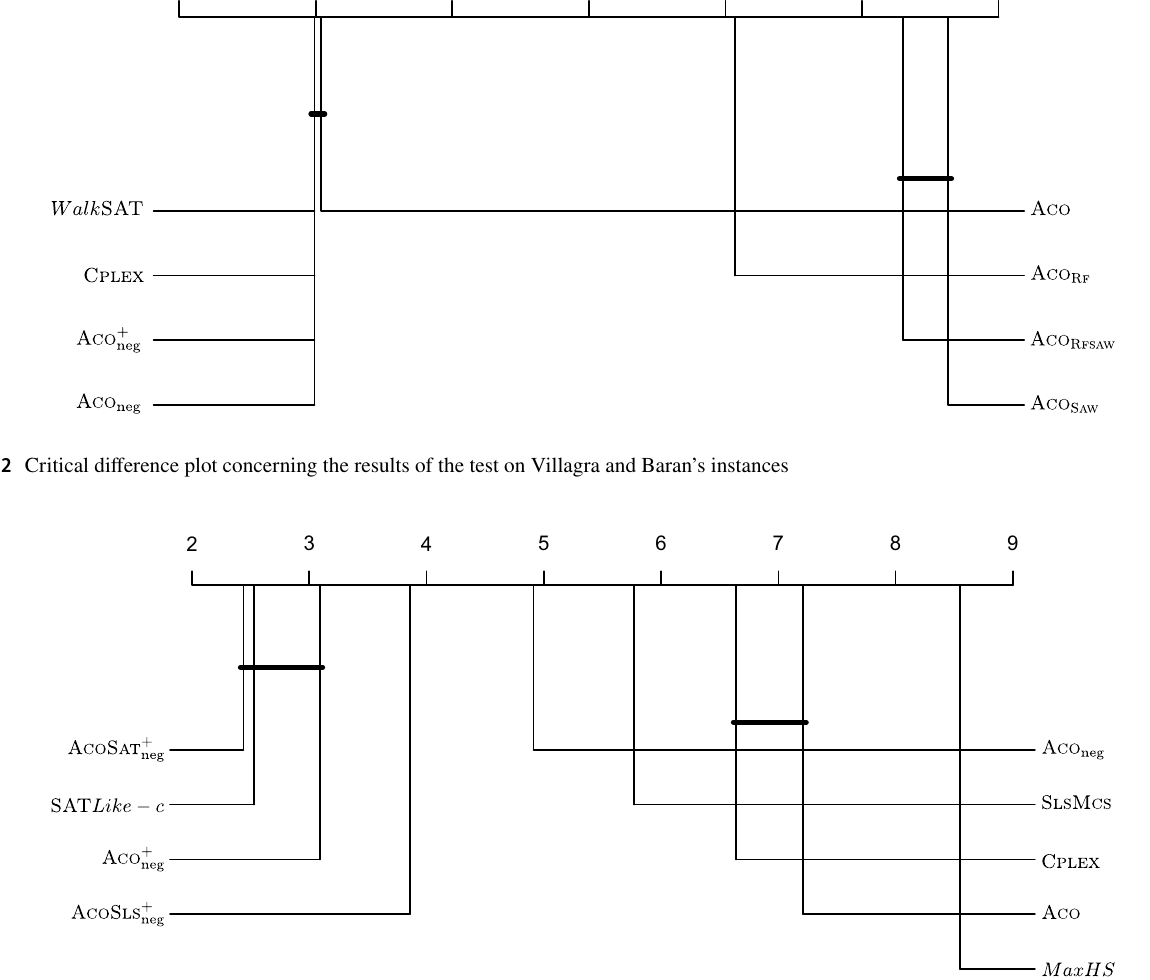
Fig. 3 Critical difference plot concerning the results of the tests for the MSE 2020 and 2016 instances